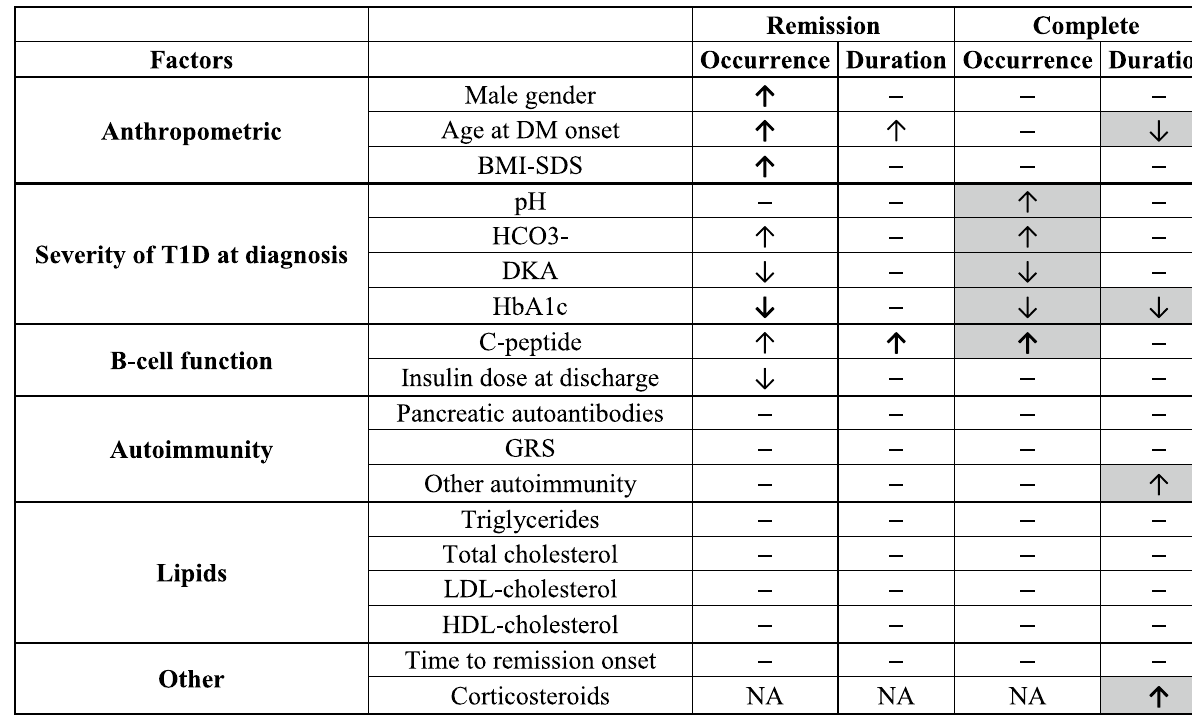
Table 4. Summary of factors influencing onset or duration of remission and complete remission in this study. BMI body mass index, SDS standard deviation score, DKA diabetic ketoacidosis, NA not analyzed. ↑ symbolizes positive association, ↓ symbolizes negative association, arrow in bold symbolizes an independent factor proved in multiple regression analysis, grey field is for not previously reported factor, and —symbolizes no significant